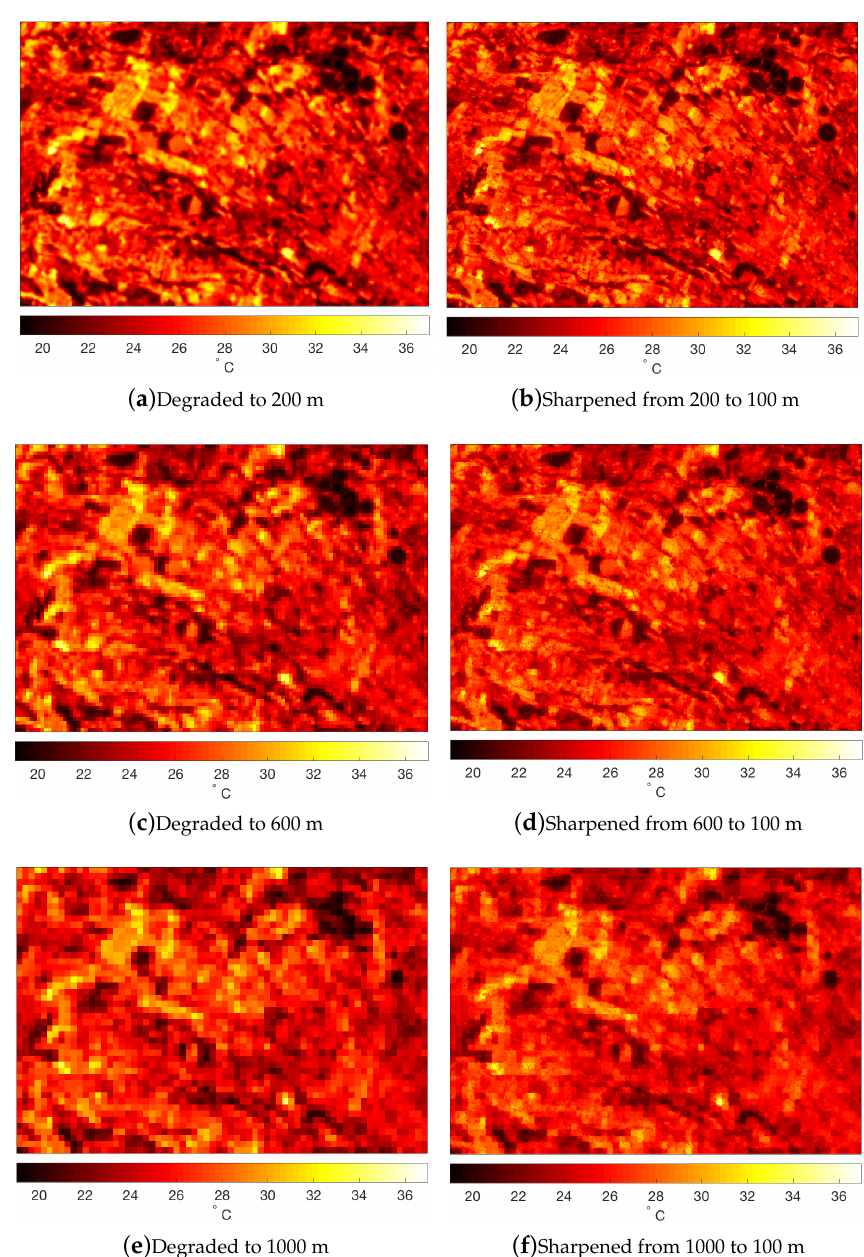
Figure 7. Visual comparison between degraded TIR 1 images and their corresponding sharpened images (100 m). The images in the left column correspond to the degraded versions at 200 ( a ); 600 ( c ) and 1000 m ( e ) respectively. Whereas in the right column, the images correspond their respective sharpened versions using the following contextual features: Scale 1 − 5 ( b ); Scale 1 − 4 ( d ); and Scale 1 − 3 ( f ). To compare the TS 2 uRF method with one of the most classic methodologies of TsHARP, described in Section 1, thermal sharpened images were generated by TsHARP, applying the same degradation levels (200 m, ..., 1000 m) and considering a minimal spatial context, i.e., the pixel level. In Table 3, it is possible to compare the quality evaluation indices (SSIM and RMSE). In all cases, the RMSE and SSIM values of the images sharpened using the TS 2 uRF method were better than for TsHARP. The greatest RMSE difference appears in the 200 m degraded TIR 1 image, obtaining a RMSE RMSE TsHARP = 1.906 ◦ C. The same applies to the structural index; the SSIM SSIM TsHARP =